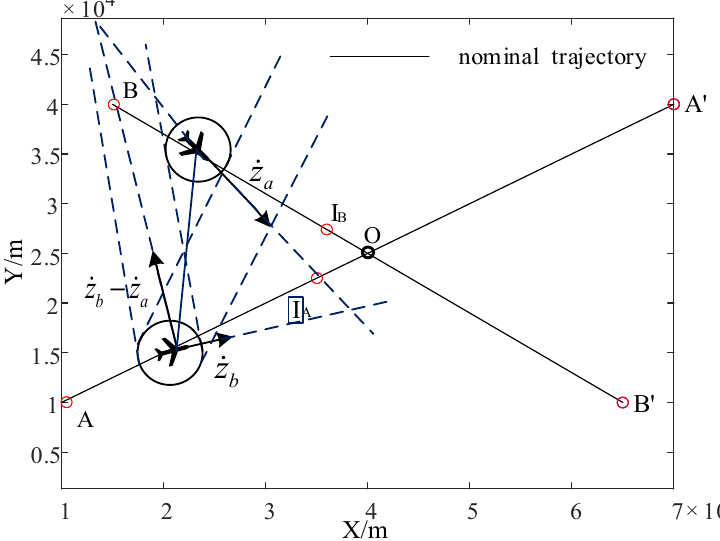
Figure 5. Conflict Detection Diagram of aircraft A and aircraft B